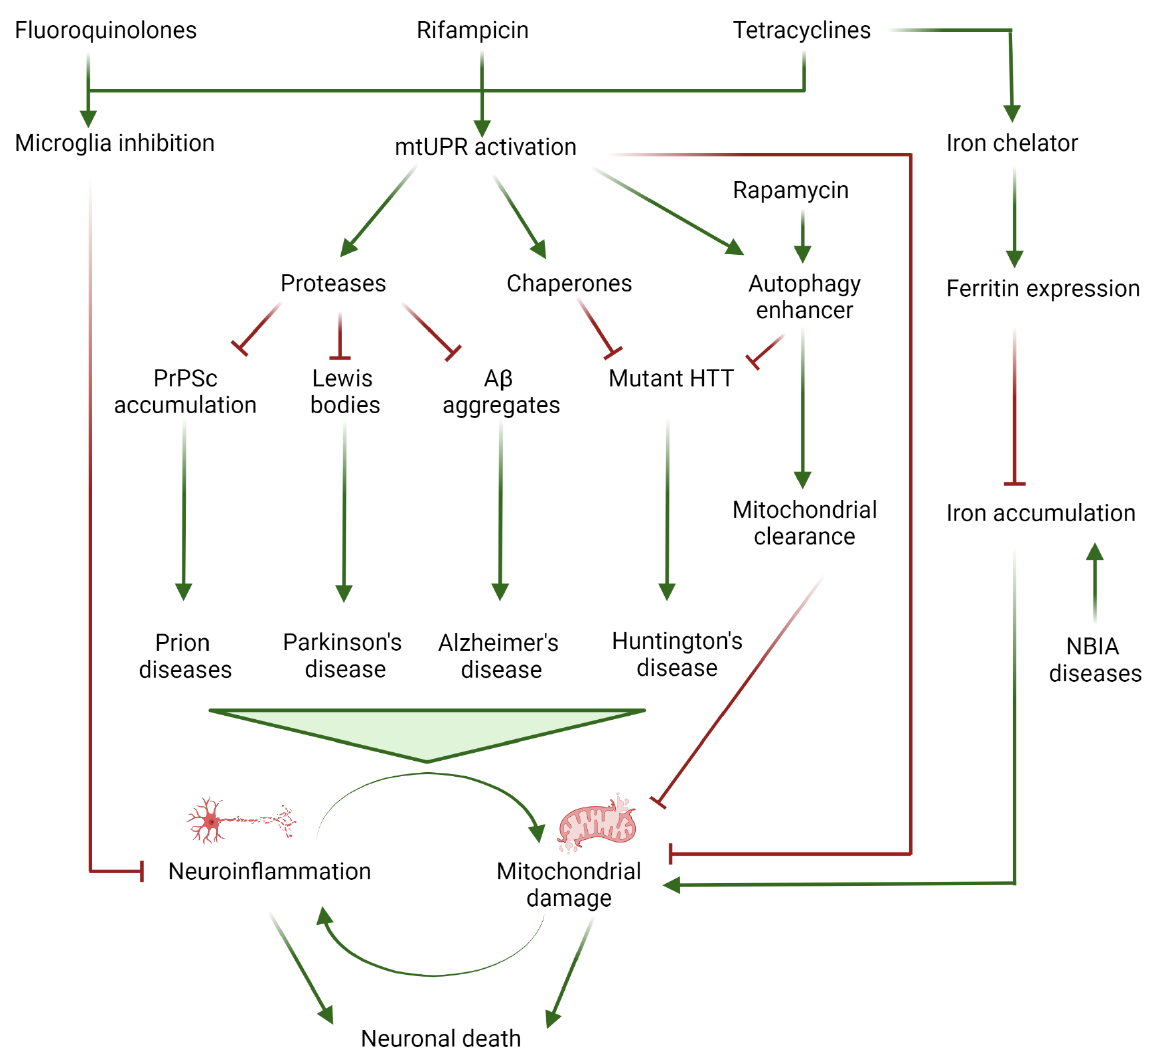
Figure 1. The proposed mechanisms of action of several antibiotics in neurodegenerative diseases. Figure 2. This is a wide figure. Although antibiotics are mainly used to treat infections, new applications are being